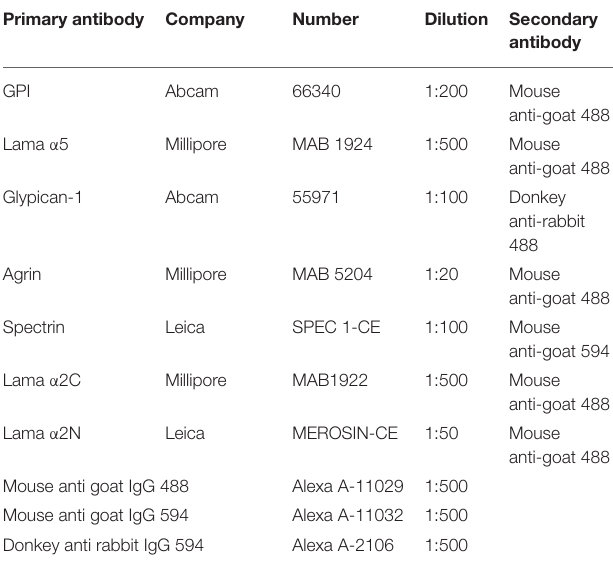
TABLE 1 | List of antibodies used for the immunofluorescence studies. Primary antibody